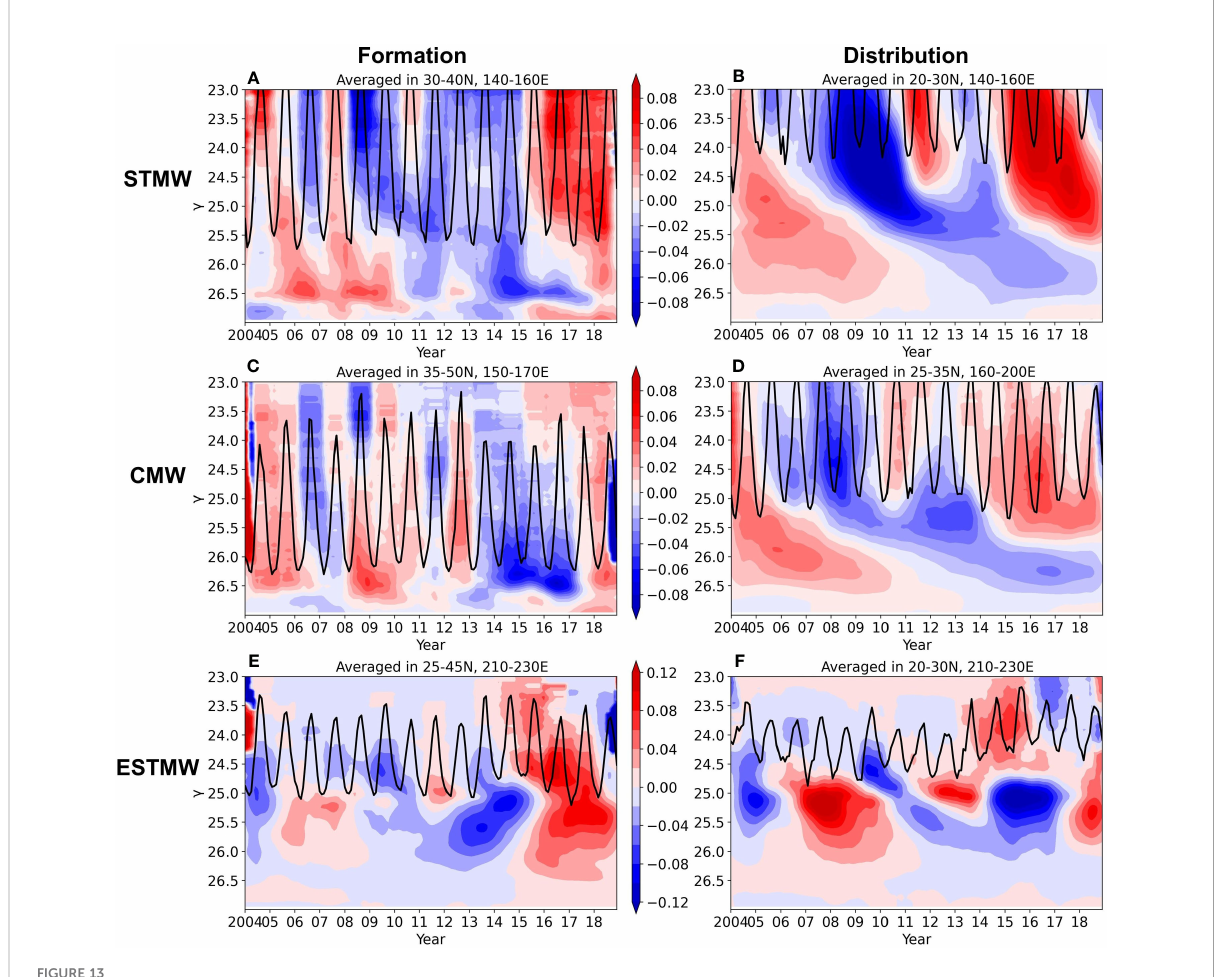
FIGURE 13 The g -time diagram for 12-month running average salinity anomalies that were averaged in boxes, which represent the formation and downstream distribution regions of the studied three mode waters. (A) 30 – 40°N, 140 – 60°E, (B) 20 – 30°N, 140 – 160°E, (C) 35 – 50°N, 150°E to 170°W, (D) 25 – 35°N, 160°E – 160°W, (E) 25 – 45°N, 130 – 50°W, and (F) 20 – 30°N, 130 – 150°W, represent STMW formation, STMW distribution, CMW formation, CMW distribution, ESTMW formation, and ESTMW distribution regions, respectively. Black contours denote the potential density of the mixed layer. The latitude ranges in A, C, and E were chosen based on Figure